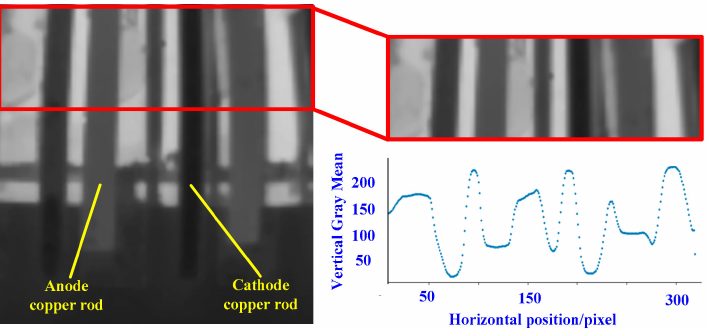
Figure 7. The original grayscale image, the captured image, and the scatter plot of the relationship between the horizontal position and vertical gray